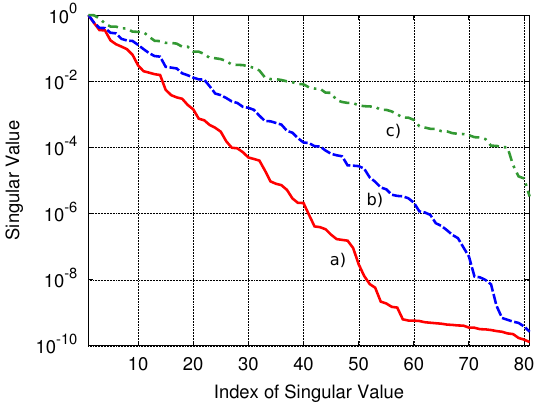
Figure 5: Singular values of the coefficient matrix C x given in Eq. (10) for three different geometries a) square plate, b) dihedral corner and c) cube as depicted in Fig. 4.